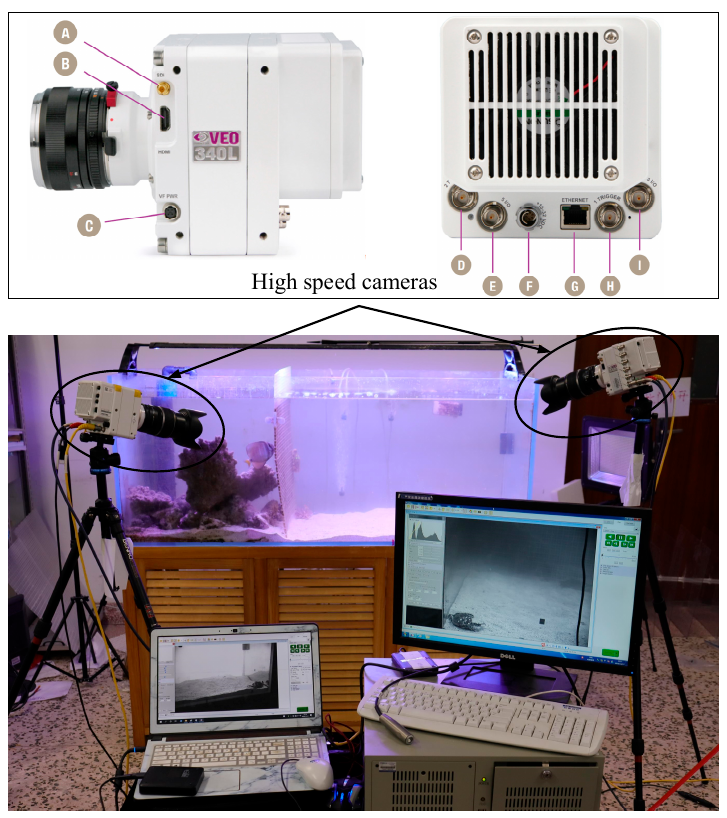
Figure 2. Observation platform. (A: SDI. B: HDMI. C: VF PWR. D: 2 TC In. E: 5 I/O. F: +16~32 VDC. G: Ethernet. H: 1 Trigger. I: 3 I/O)